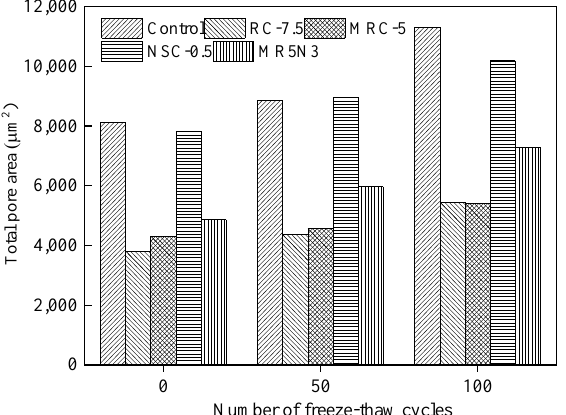
Figure 9. Influence of freeze–thaw cycles on total pore area.